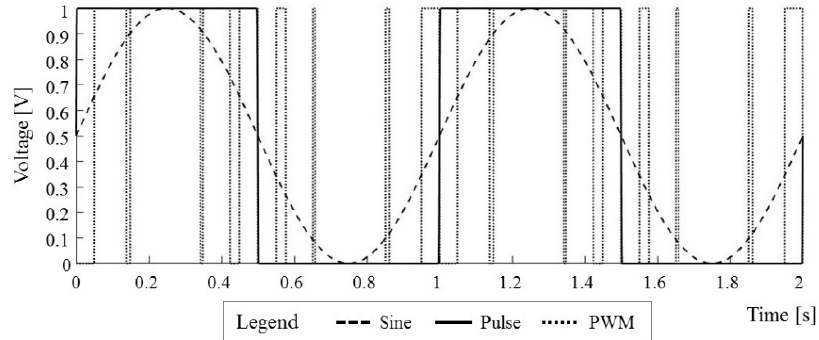
Figure 10. Top boundary condition waveforms.